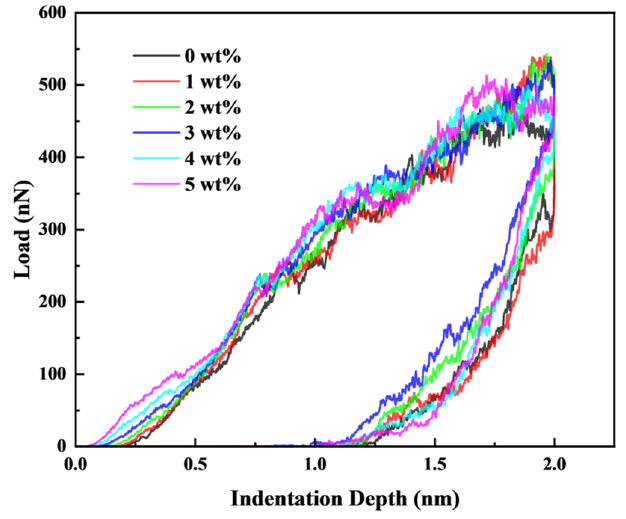
Figure 2. Load–displacement curves for nanoindentation under various Zr content by simulation. According to Equations (4)–(8), material properties about hardness H , reduced elastic modulus E r , and elastic modulus E with the change in Zr content from the nanoindentation simulation were calculated as shown in Table 1. With the increment of Zr content, the Nb-Zr alloy shows larger hardness than the pure Nb material within 4 wt.% range. In addition, the content of 1 wt.% Zr seems to be the inflection point of the hardness of Nb-Zr materials which is in agreement with the trend of that obtained from the experiment. The hardness of 1.06 wt.% (approximately 1 wt.%) was also acquired by the nanoindentation experiment with a value of 13.23 GPa. By comparison, the hardness with 1 wt.% Zr addition of simulation result is very close to that in the experiment, with a relative error of 3.08%, therefore showing the reliability of the simulation and the rational use of the potential